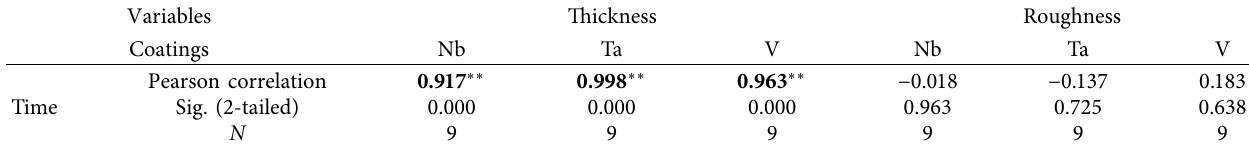
Table 8: Sputtering time correlations with thickness and roughness of